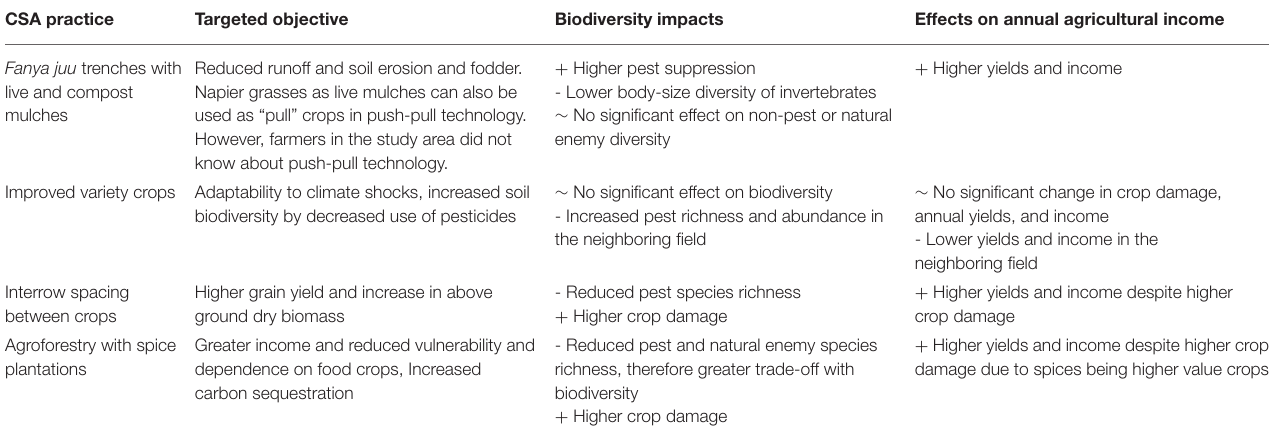
TABLE 3 | Trade-off and synergies among the targeted objectives, biodiversity and annual income returned in the study area. CSA